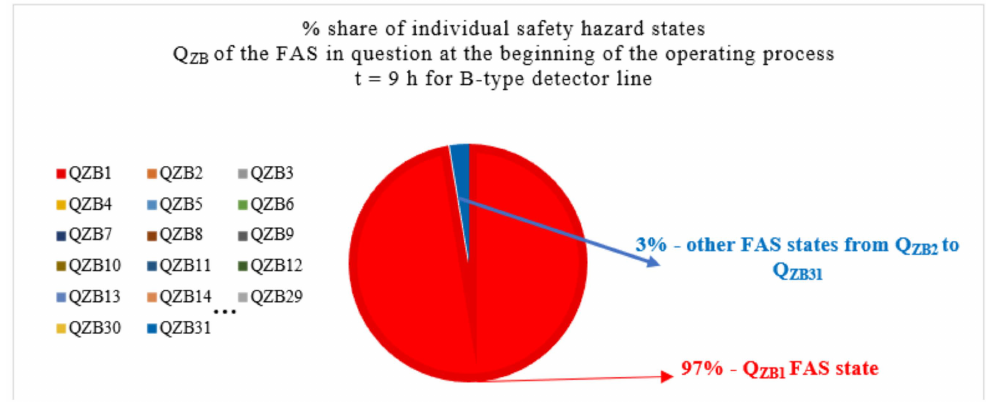
Figure 21. Percent share of individual safety hazard states Q ZB of the FAS in question, at the beginning of system operation, for t = 9 h (own